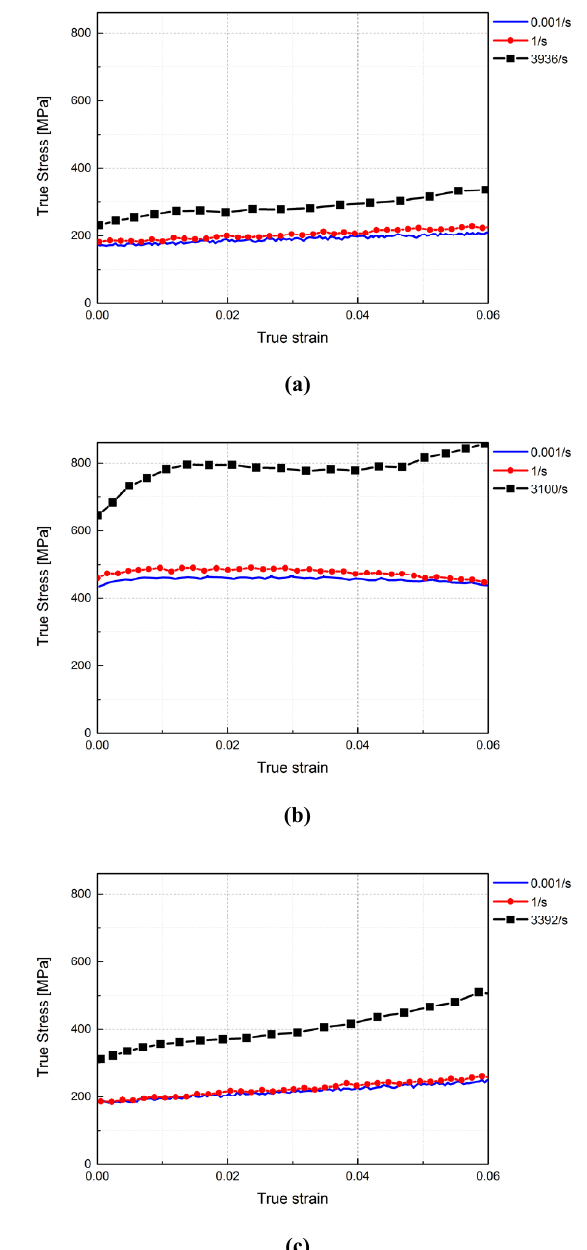
Fig. 6. True stress-strain curves of OFHC copper at different strain rates (a) Forged OFHC copper, (b) ECAPed OFHC copper, (c) 200 ℃ , 1 h heat treated OFHC copper after ECAP